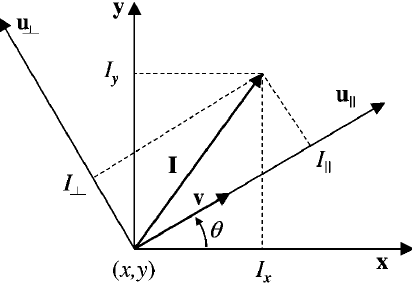
FIG. 3. Definition of parameters for a stretched wire measure-